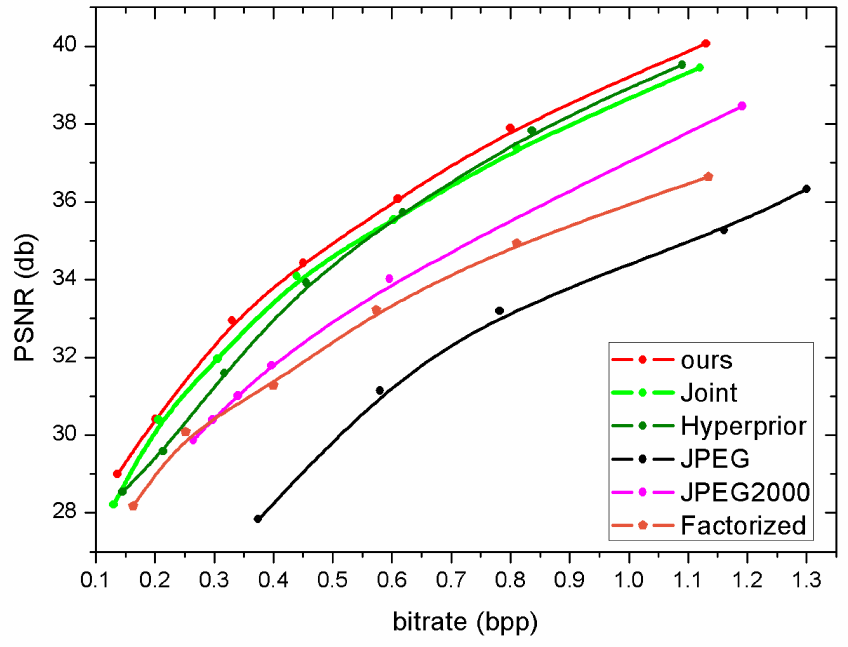
Figure 7. The rate-distortion compression performance of the proposed algorithm and comparison algorithms. The rate is measured by bit per pixel (bpp) and distortion is measured by PSNR.